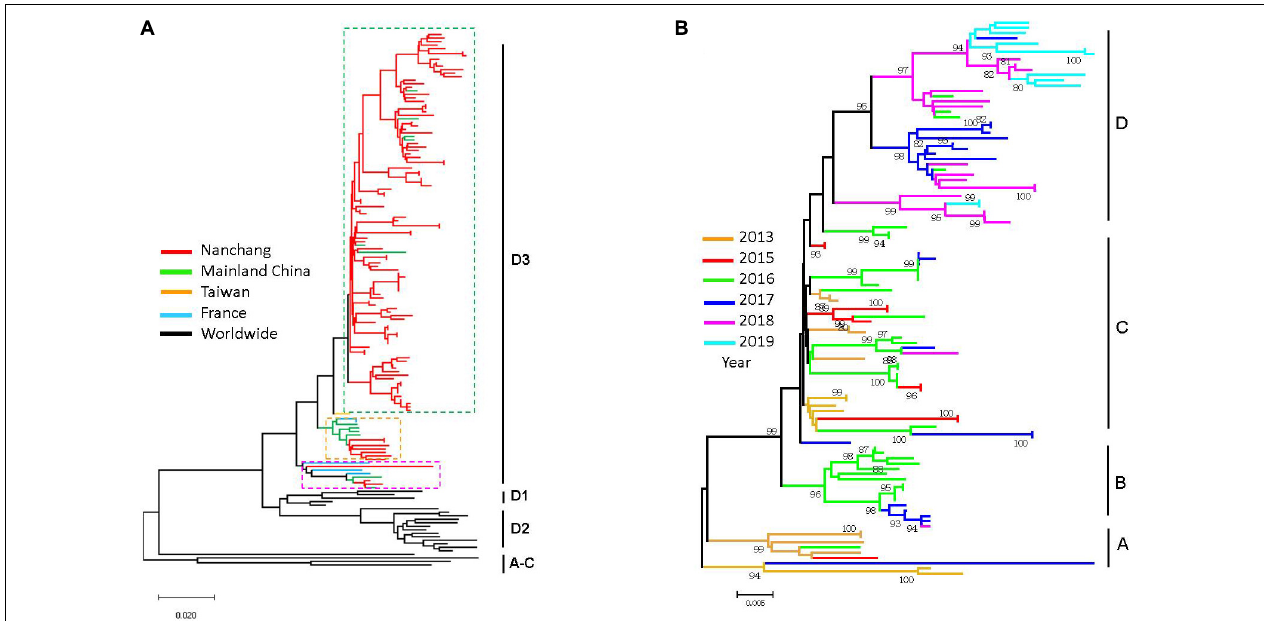
FIGURE 6 | Characteristics of age distribution of HFMD cases (A) and enterovirus distribution of different serotypes in different age groups (B,C) .